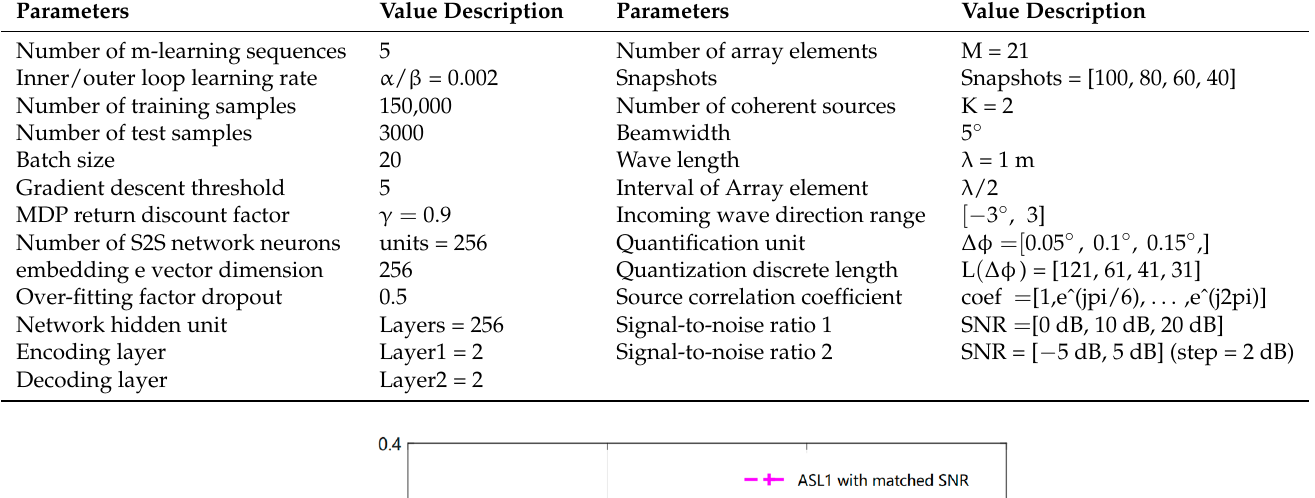
Table 1. Simulation Parameters.